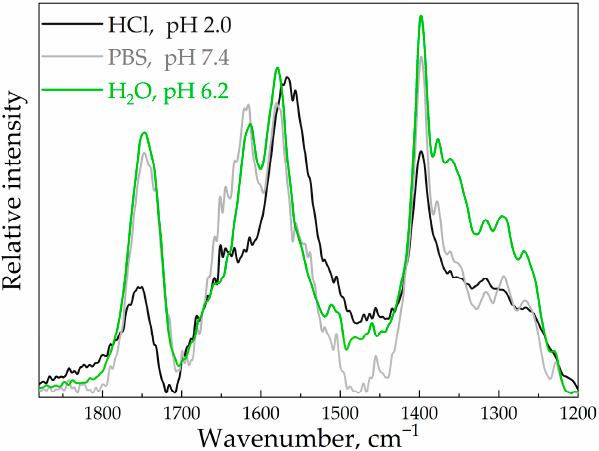
Figure 3. The normalized FTIR spectra of MP in acidic (pH 2.0; HCl), neutral (distilled water), and slightly alkaline (pH 7.4; 0.01 M sodium-phosphate buffer solution) media, 22 °C. slightly alkaline (pH 7.4; 0.01 M sodium-phosphate buffer solution) media, 22 ◦